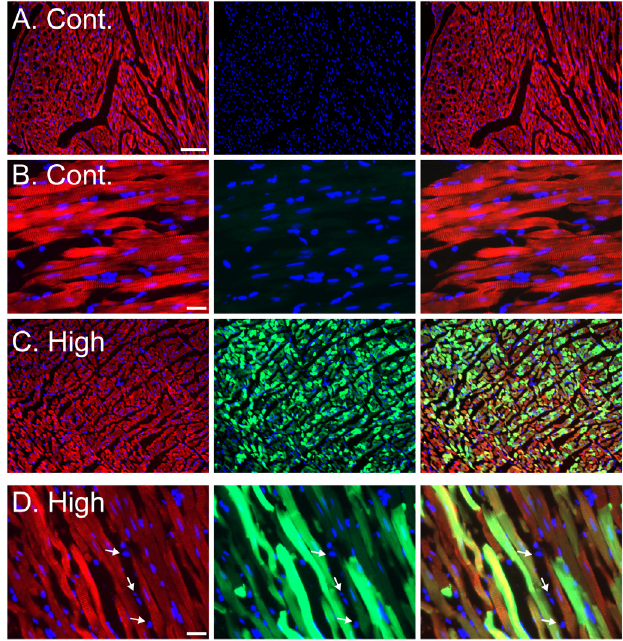
Figure 4. Cardiomyocyte specific expression of GFP in adult rats injected with AAV9-cTnT-eGFP. A – B . Representative images of cardiac sections of control rats ( A – low magnification, Bar= 100 µm; B - High magnification Bar= 20 µm). C – D . Representative images of cardiac sections of ‘high dose’ AAV injected rats ( C – low magnification, Bar= 100 µm; D - High magnification Bar= 20 µm). For all panels ( A – D ) staining with sarcomeric α actinin immunostaining (red), eGFP fluorescence (green) and DAPI nuclear stain (blue). Left column of panels shows a composite of actinin (red) and DAPI (blue) channels, middle column shows a composite of GFP (green) and DAPI (blue) channels, and right column of panels shows a composite of all three actinin (red), GFP (green) and DAPI (blue) channels. No green GFP fluorescence is seen in cardiomyocytes from control saline injected rats ( A – B ), and ~100% of cardiomyocytes show green GFP fluorescence in the high dose AAV9-cTnT-eGFP injected rats ( C - D ). Importantly, non-cardiomyocyte cells, likely cardiac fibroblasts, identified by the lack of sarcomeric α actinin immunostaining do not show GFP fluorescence even in the high dose AAV9-cTnT-eGFP injected rats, demonstrating the expression is restricted to cardiomyocytes ( D , arrows). Bar = 20 µm.